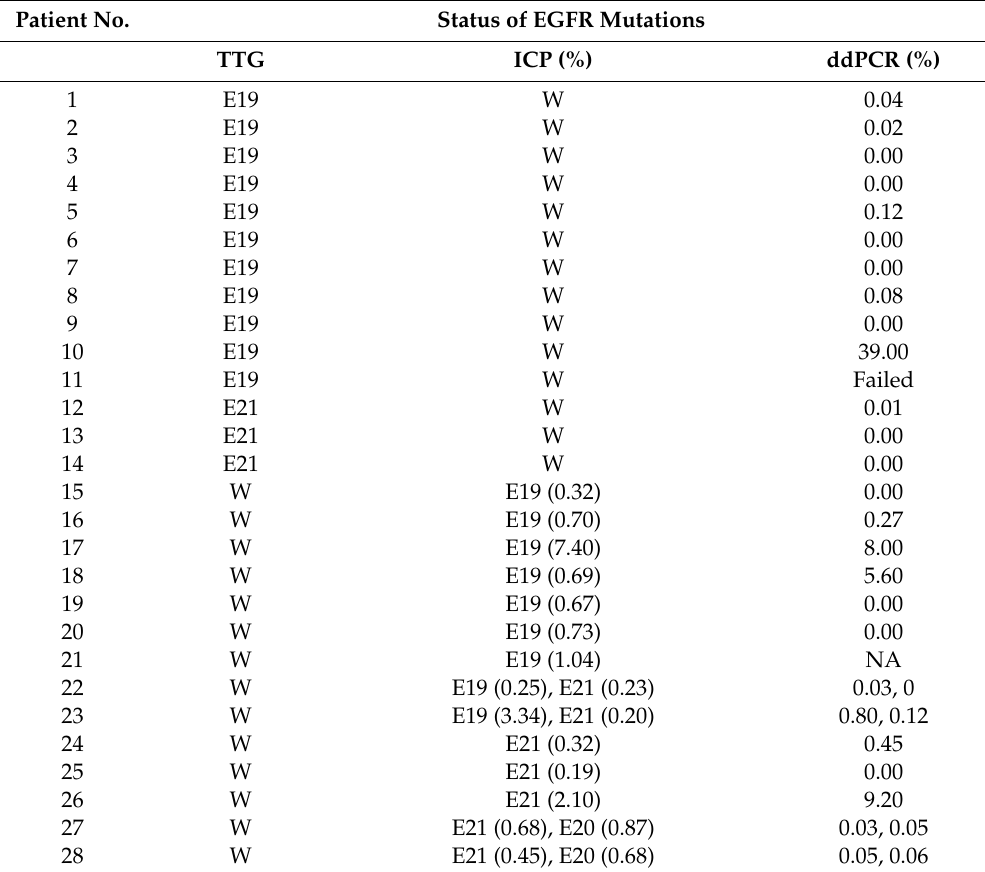
Table 1. Validation of ddPCR in patients with discordant EGFR mutation status between TTG and ICP, and in those with EGFR mutations in ICP analysis, not tested in tumor tissue. Patient No. Status of EGFR Mutations TTG ICP (%) ddPCR